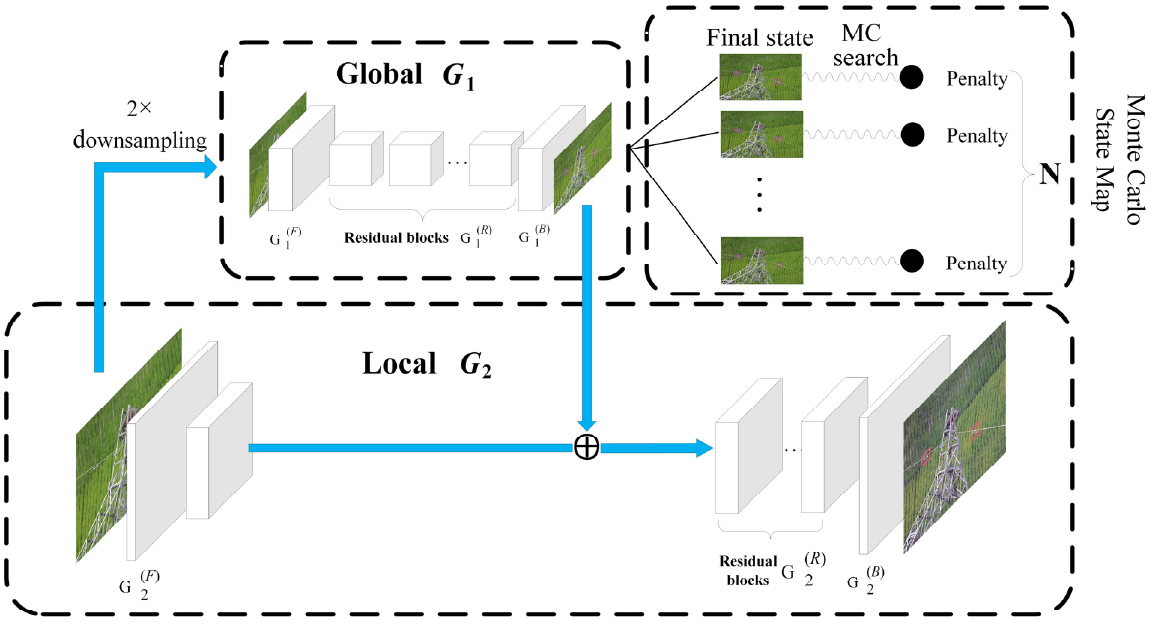
Figure 3. The framework of the generator containing three parts: the global module, the Monte Carlo search, and the local module. First, we used the global module to obtain the LR image; then, we used the Monte Carlo for detail mining; and finally, we used the local module to obtain the HR image. The global generator consists of three parts: front-end convolution layer G ( R ) block G , and transposed convolution back-end G 1